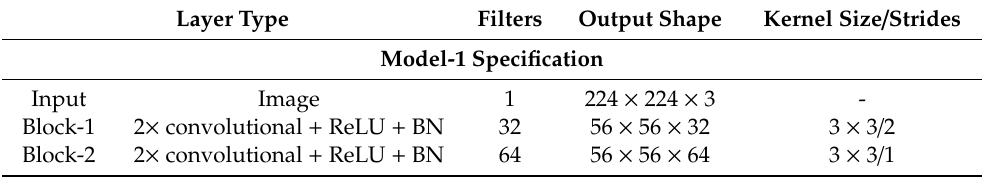
Figure 6. Structure of our lightweight convolutional neural networks for cancer image classification between two Gleason grade groups of prostate carcinoma. Spatial features are extracted from an image by convolving through one of the networks. Classification layers (flatten, global average pooling [GAP], dense-1, dense-2, and output) were used to find the required response based on features that were extracted by the convolutional neural network. Table 2. Detailed information and specifications of lightweight convolutional neural network models.